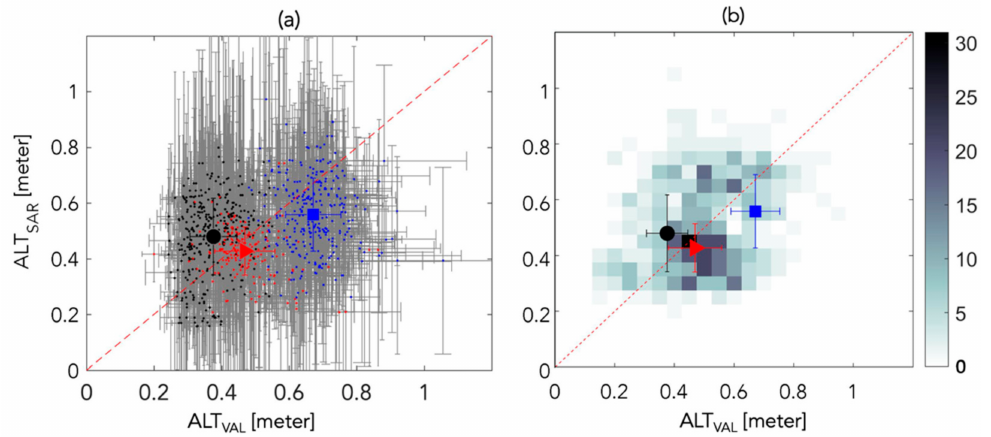
Figure 4. ( a ) ALT validation data compared against the collocated SAR result. Grey bars are individual estimated uncertainties (vertical error bars indicate posterior uncertainty for the PDO product; horizontal error bars indicate validation uncertainty from error propagation of the GPR errors, scaling errors, and representation errors); large colored markers are the average and standard deviations for each swath. ( b ) A 2D histogram, where grayscale indicates count, displaying the same data as in panel ( a ). Black, BRW; red, TOO; blue,